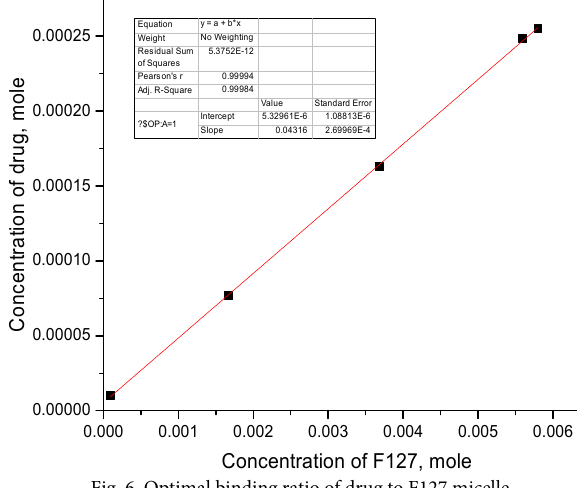
Fig. 6. Optimal binding ratio of drug to F127 micelle. Table 7. the added oil+drug (in 1:1 molar ratio) amount into the solution of Pluronic F127 and sodium caprylate (SC) in PBS to find the upper limit of solubilization the oil+drug in the solution ([F127]=0.009 M , [Sodium Caprylate (SC)]= 2.641 M)